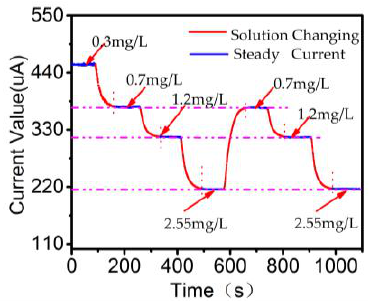
Figure 7. Data recording and analysis of different test process. The current value changes to a steady value for different solution exchange.